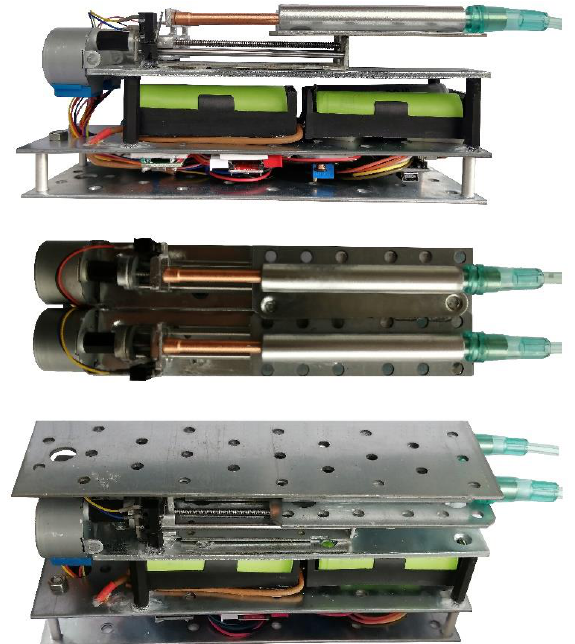
Figure 9. The first prototype of the two-axis automatic continuous distractor.